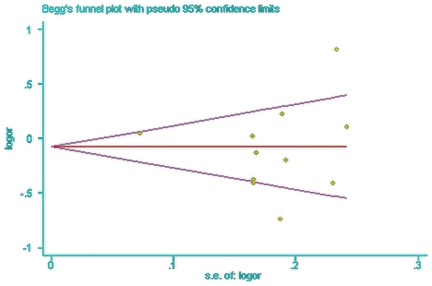
Begg's funnel plot analysis for the comparison of the SNP+276 alleles.P value of Begg's test was 0.76 (continuity corrected).